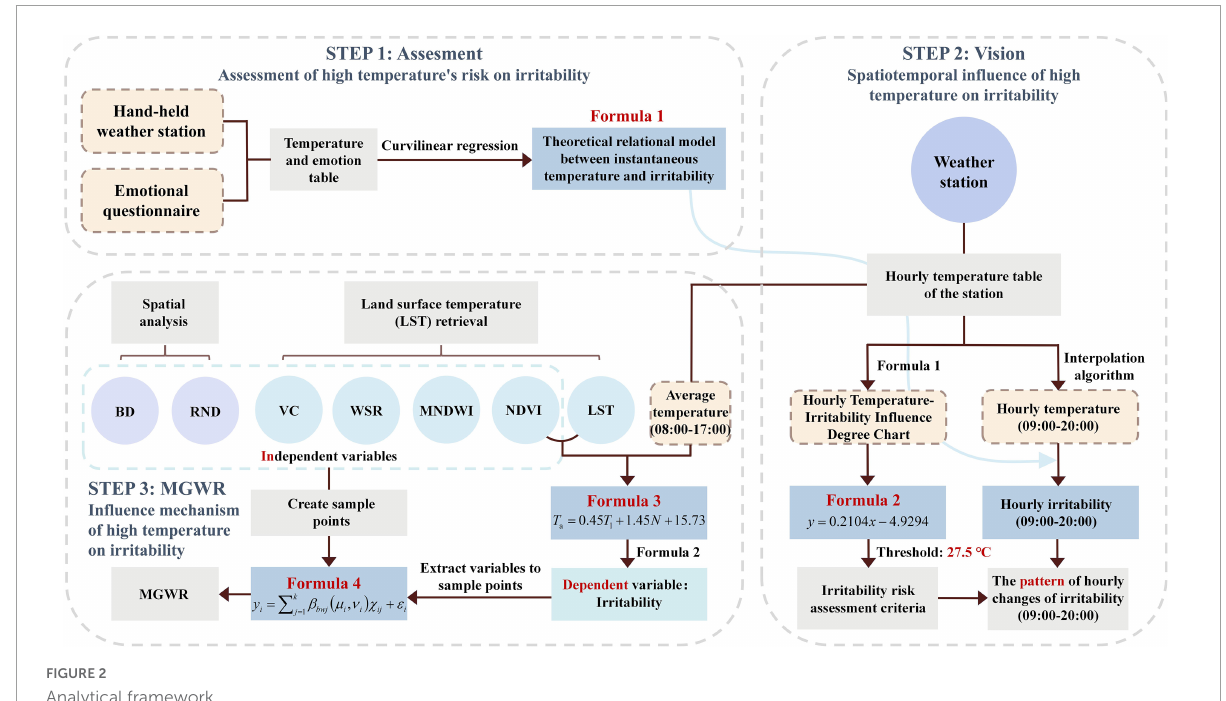
FIGURE2 Analytical framework.